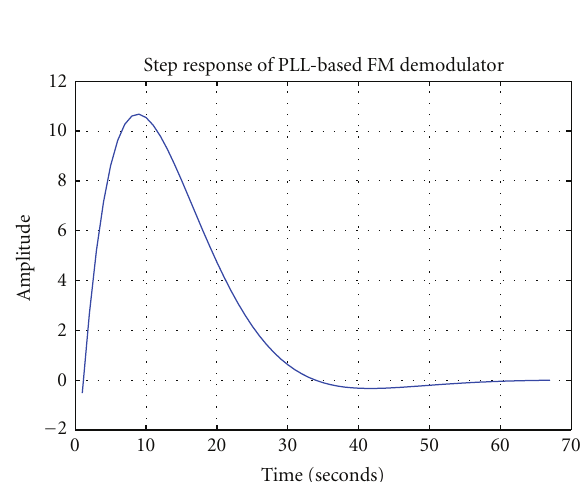
Figure 6: Unit step response for PLL system used in FM demodu- lator.